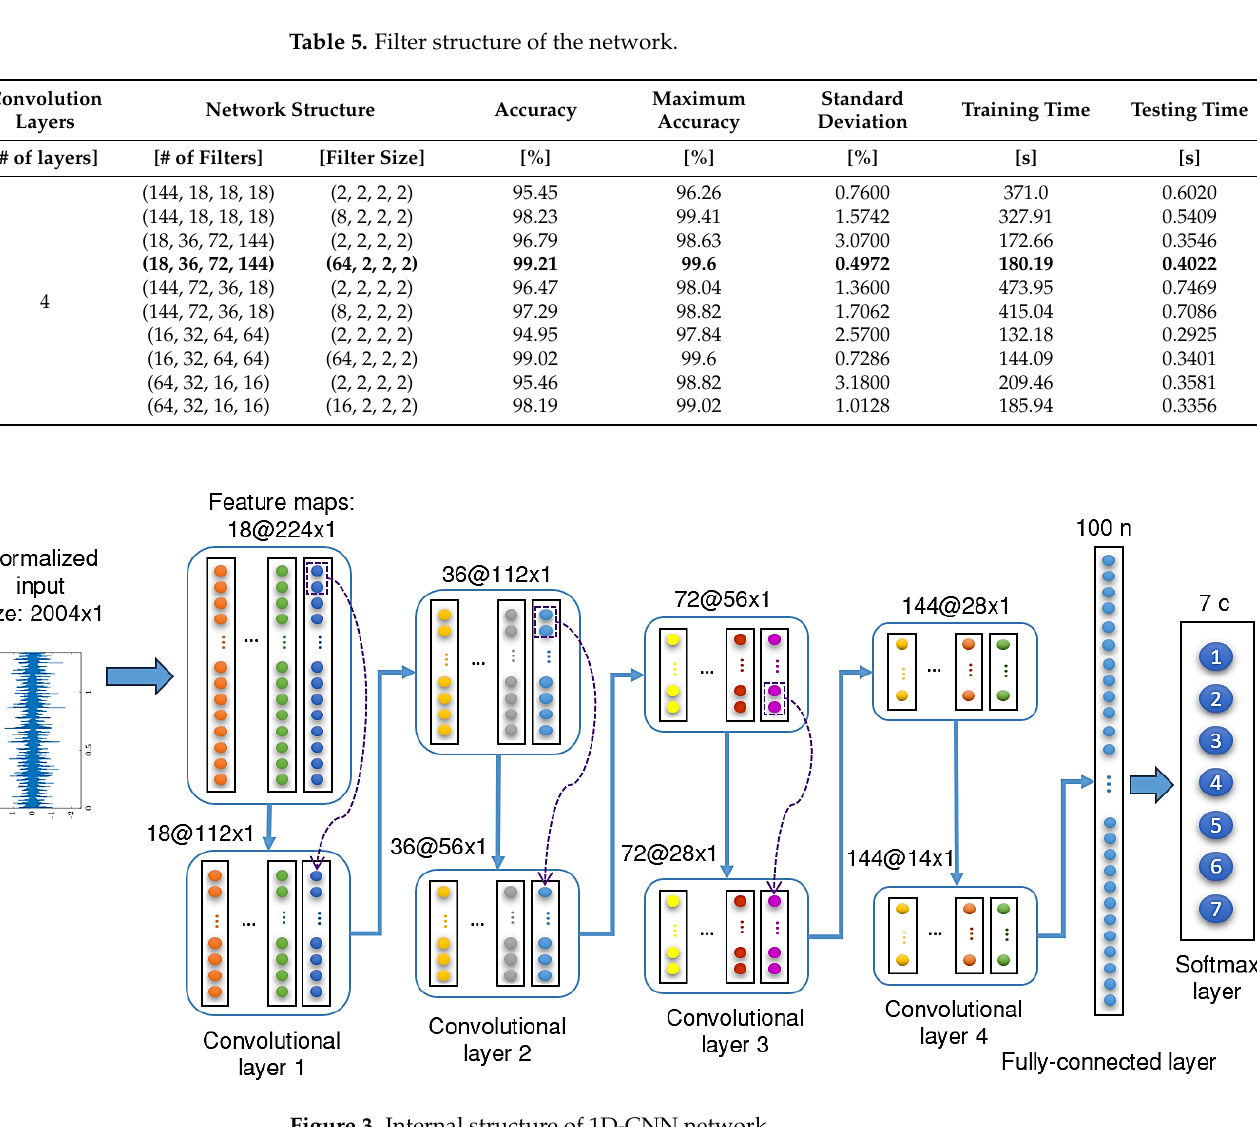
Table 4. 1D-CNN structure. Layer